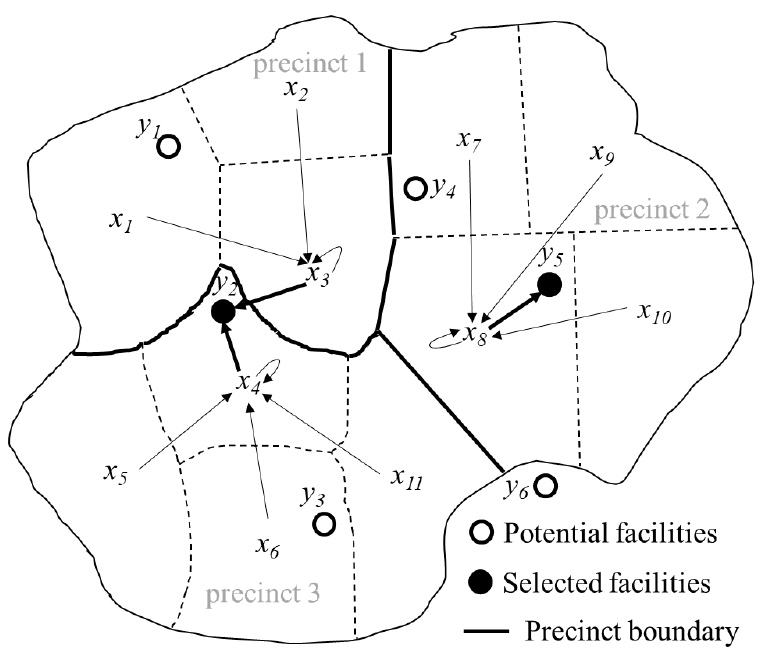
Figure 1. Double location-allocation process of the capacitated double p -median problem with preference (CDPMP-P).